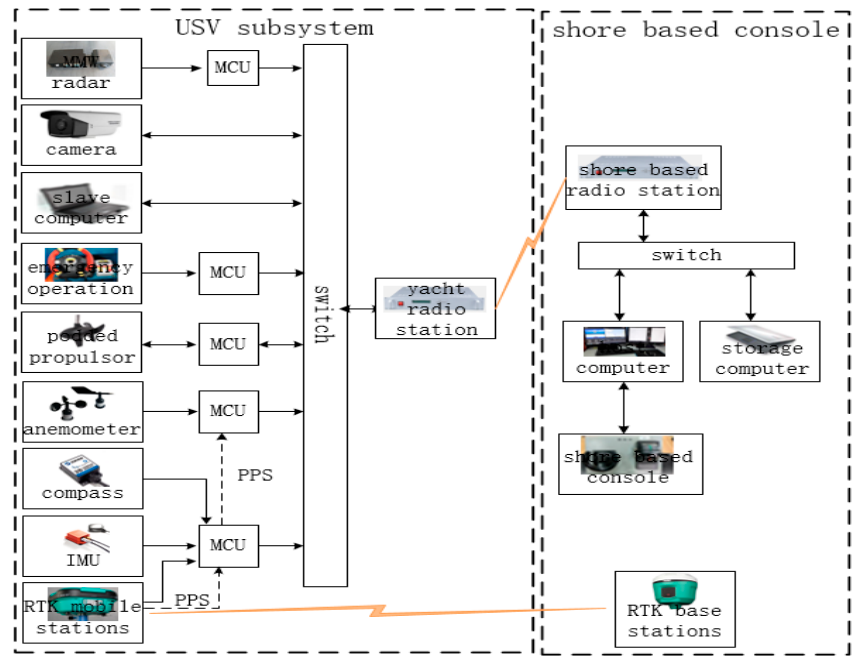
Figure 12. The system architecture of the iNav-II USV.